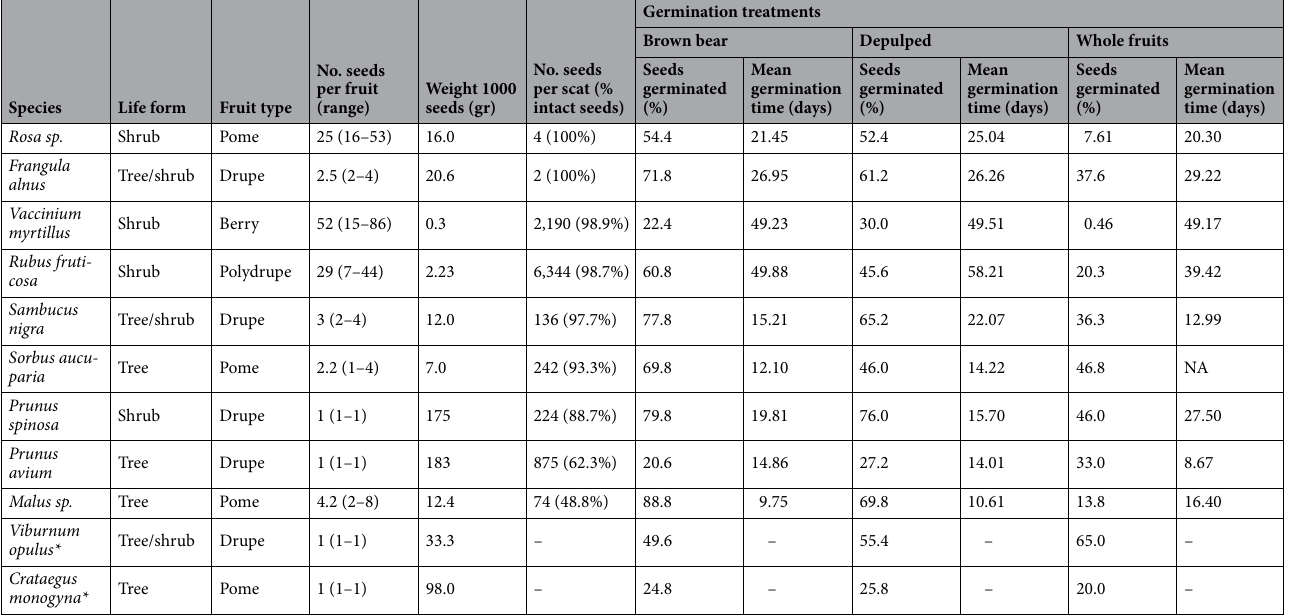
Table 2. Characterization of some of the quality and quantity components of brown bear seed dispersal for 11 fleshy-fruited plant species commonly eaten by brown bears in Eurasian temperate forests. The table shows the life form (tree, shrub or both), fruit type (berry, drupe, polydrupe or pome), number of seeds per fruit (average and range), average weight of 1,000 seeds (gr—information extracted from the Kew Royal Botanical Garden), average number of seeds found per bear scat (n = 100 scats containing fleshy fruits) and the percentage of seeds that remain intact after bear ingestion. The results of the germination experiment are also shown and include the percentage of seeds germinated at the end of the 2-year experiment and the mean germination time during the first year of germination (in number of days elapsed since April 1st) for the three treatments (Brown bear- seeds ingested by bears and recovered from the scats, Depulped-manually depulped fruits, and Whole fruits- seeds embedded within the whole fruit). * Asterisks mark species that only germinated during the second year of germination.